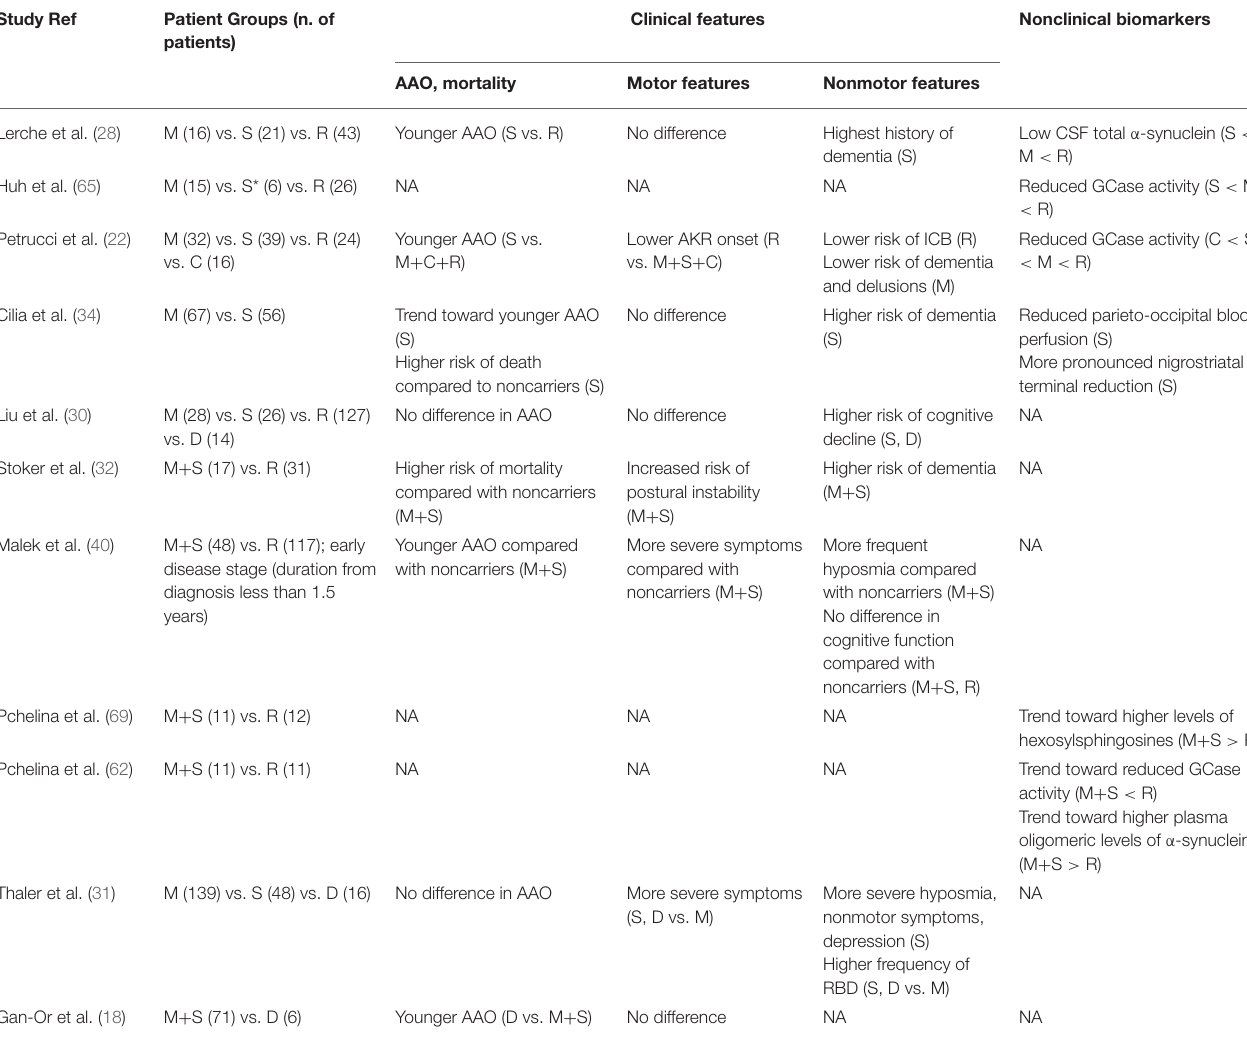
TABLE 1 | Summary of main studies reporting genotype–phenotype correlations in GBA -Parkinson